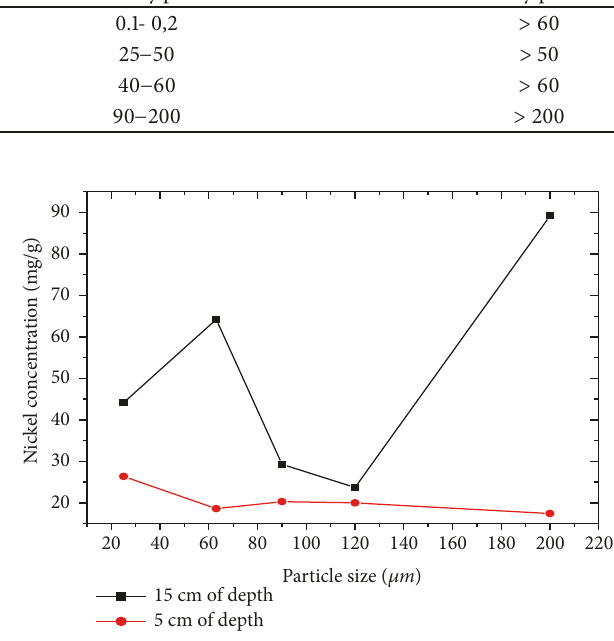
Figure 9: Evolution of nickel concentrationas a function of particle size and depth.